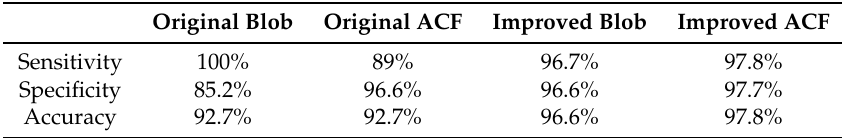
Table 2. The three performance metrics computed on the results reached by the two algorithms, both in their old version and in the new one with Motion Check and